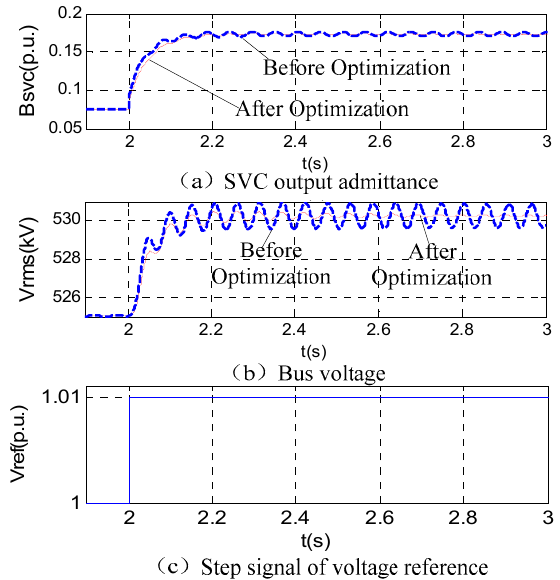
Figure 13. Simulation comparison of SVC parameters before and after optimization.